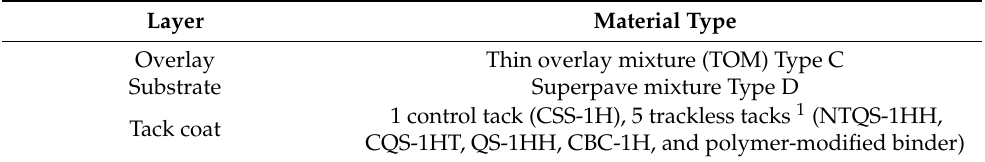
Table 1. Material types used in the mixture